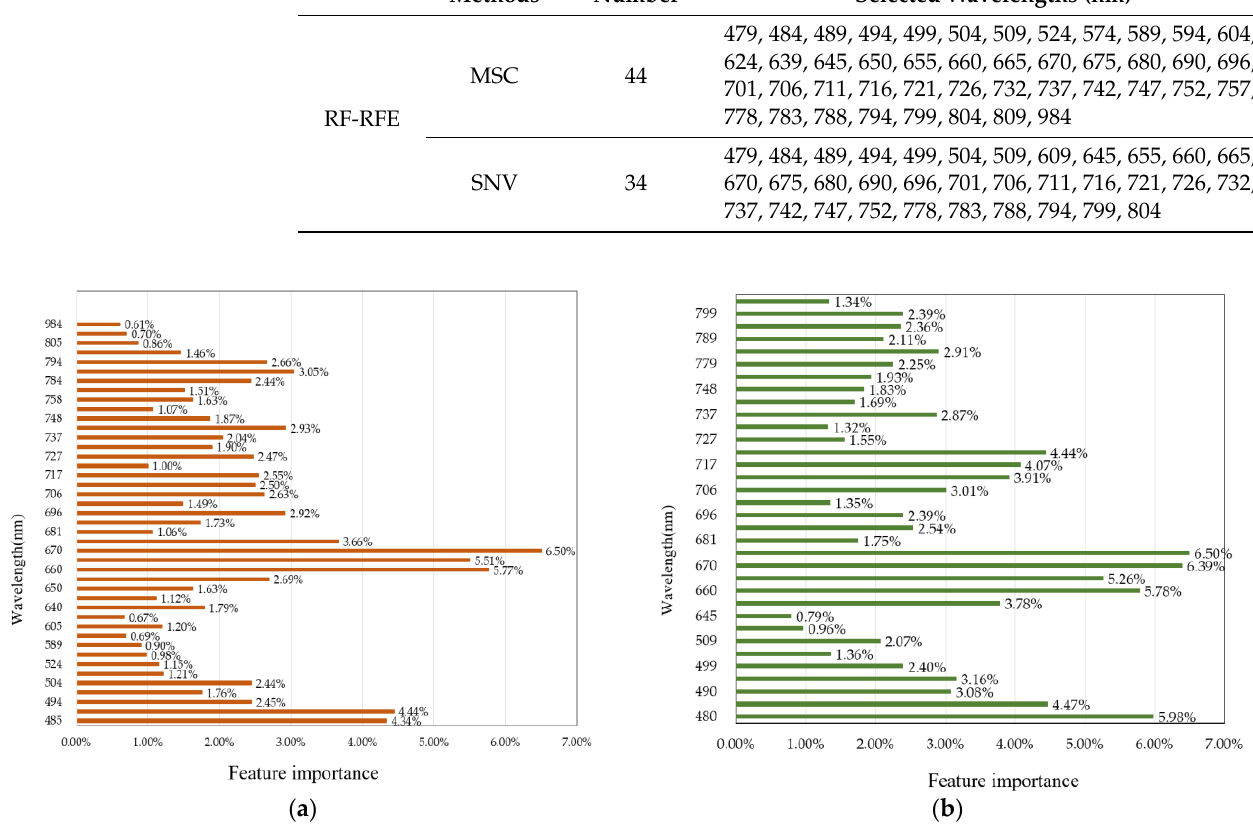
Figure 11. Feature bands selected by different algorithms. ( a ) MSC-RF-RFE, ( b ) SNV-RF-RFE.